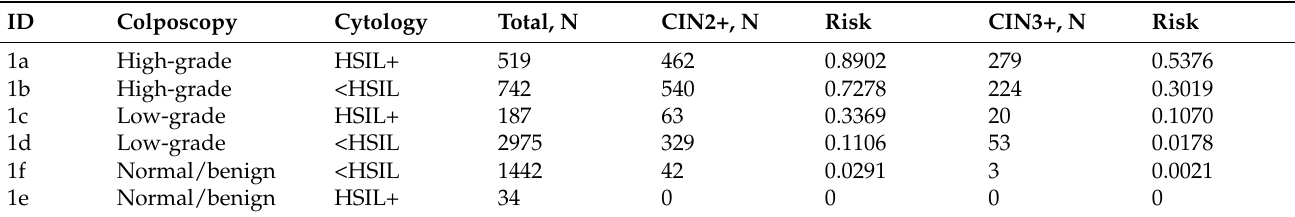
Table 3. Cervical precancer risk strata based on colposcopy and cytology.